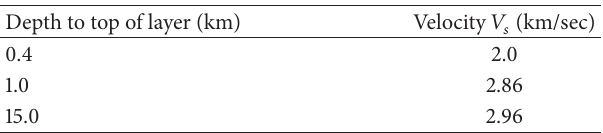
Table 1: Velocity model used for present work, given by Yu et al.